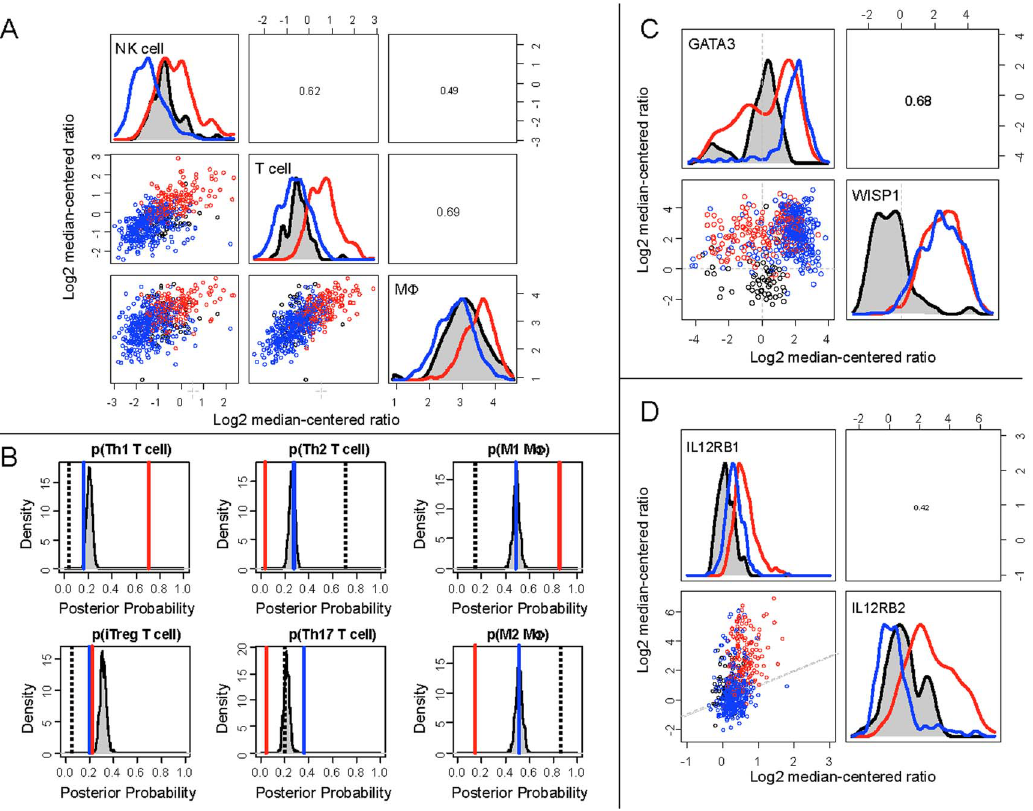
Figure 3. Gene expression clusters associated with invasive breast cancer exhibited differential cell-mediated immune response relative to normal breast tissue. Relative immune cell infiltrate was estimated based upon the average expression of genes associated with NK cells, T cells, and macrophages, as listed in Table 1 (A). Mean posterior probability associated with T helper cell and macrophage polarization in each group (Group 1 - blue line, Group 2 - red line, Normal - black dotted line, random gene expression (null hypothesis) - gray shaded density distribution) were estimated based upon mutually exclusive gene expression patterns that are associated with each cell subset, as also listed in Table 1 (B). WISP1 expression was increased in breast cancer relative to normal tissue samples and WISP1 expression correlated with GATA3 expression (C). The ratio of IL12RB2 to IL12RB1 was increased in Group 2 patients relative to Group 1 patients and normal breast tissue samples (D). A 1:1 ratio between IL12RB2 and IL12RB1 gene expression is indicated by the gray dotted line in the scatter plot. In panels A, C, and D, bivariate scatter plots are shown below the diagonal, marginalized histograms stratified by the three groups are shown on the diagonal, and correlation coefficients are shown above the diagonal. Results are colored by group (Breast Cancer Group 1: blue, Breast Cancer Group 2: red, Normal breast tissue: